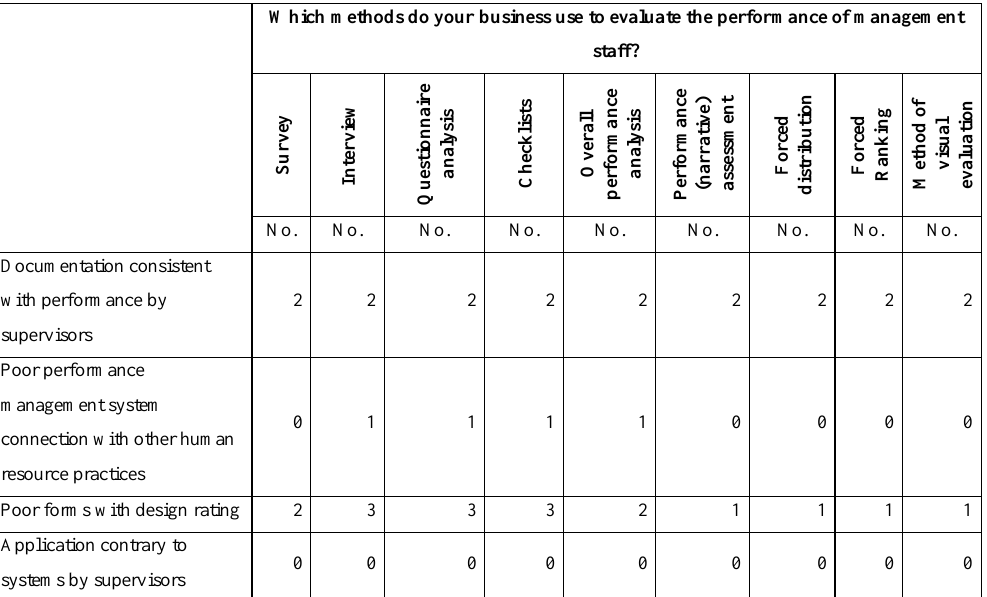
Table 6. Types of Methods for Managerial Staff Performance Assessment and the Ability to Experience the Challenges as Influencing Factors of Credibility